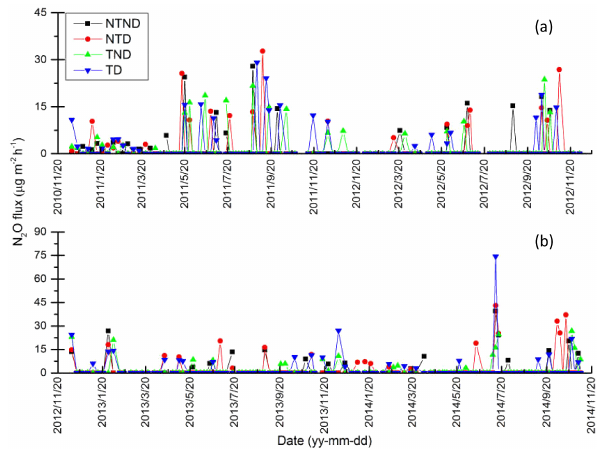
Figure 2. Seasonal variation of N 2 O emission from 2010 to 2014.